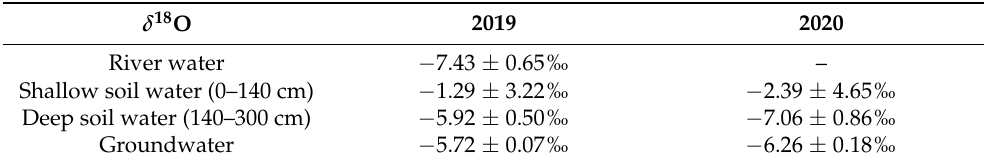
Figure 2. Variations in the vertical profiles of soil water content ( A ) and δ 18 O values ( B ) at the 0–300 cm soil layers in 2019 and 2020 (mean ± SD, n = 3). Table 2. Characteristics of the variations of δ 18 O in potential water sources during the study period (mean value ± standard